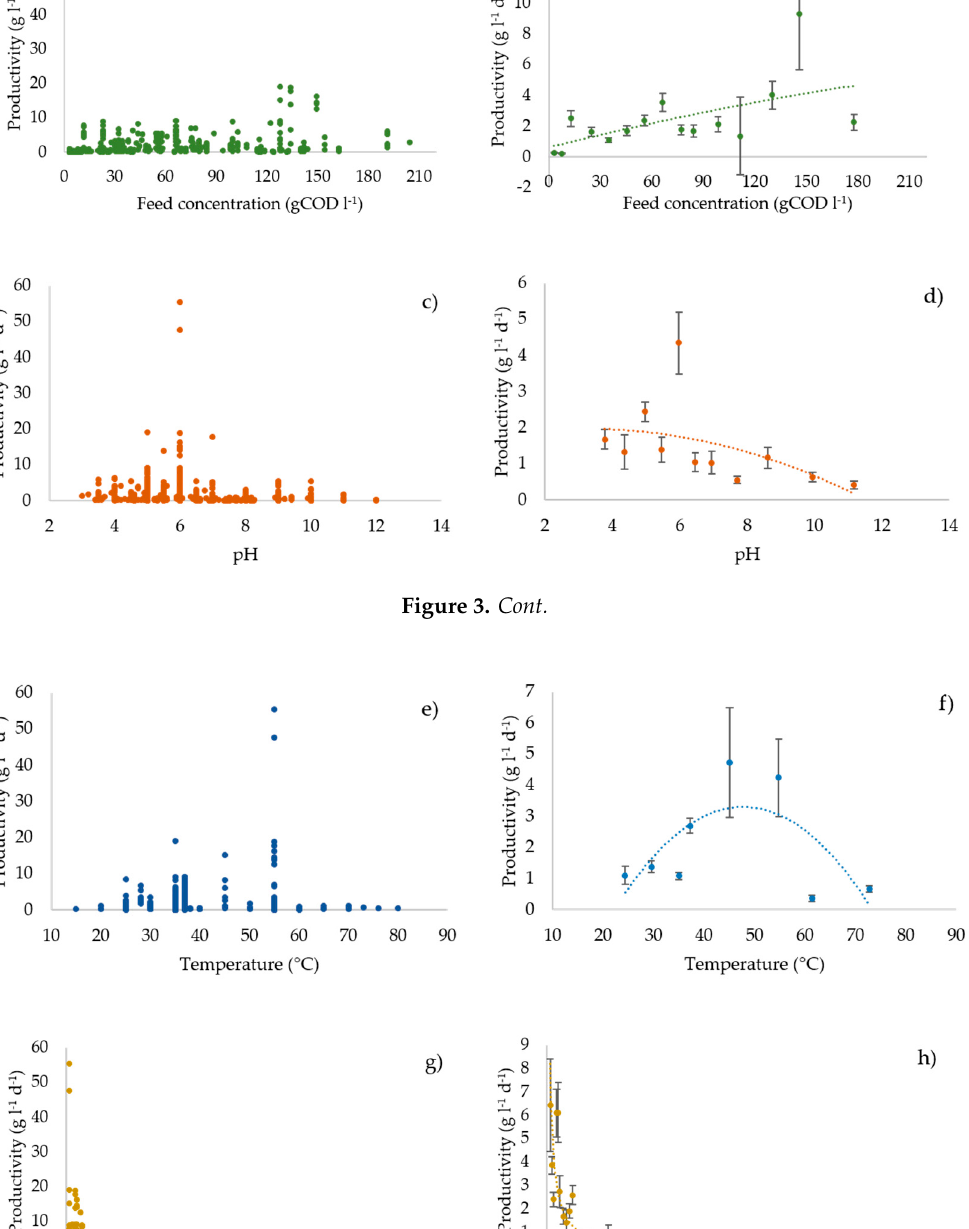
Figure 2. Relationships between product yield and operating parameters. ( a , c , e , g ) All the considered experiments. ( b , d , f , h ) Average values of experiments in each narrow range (width maximum 20%) of the operating parameters (error bars indicate the standard error) with second grade polynomial curve. The polynomial curve is only used to visualise the general trend, without any statistical significance.